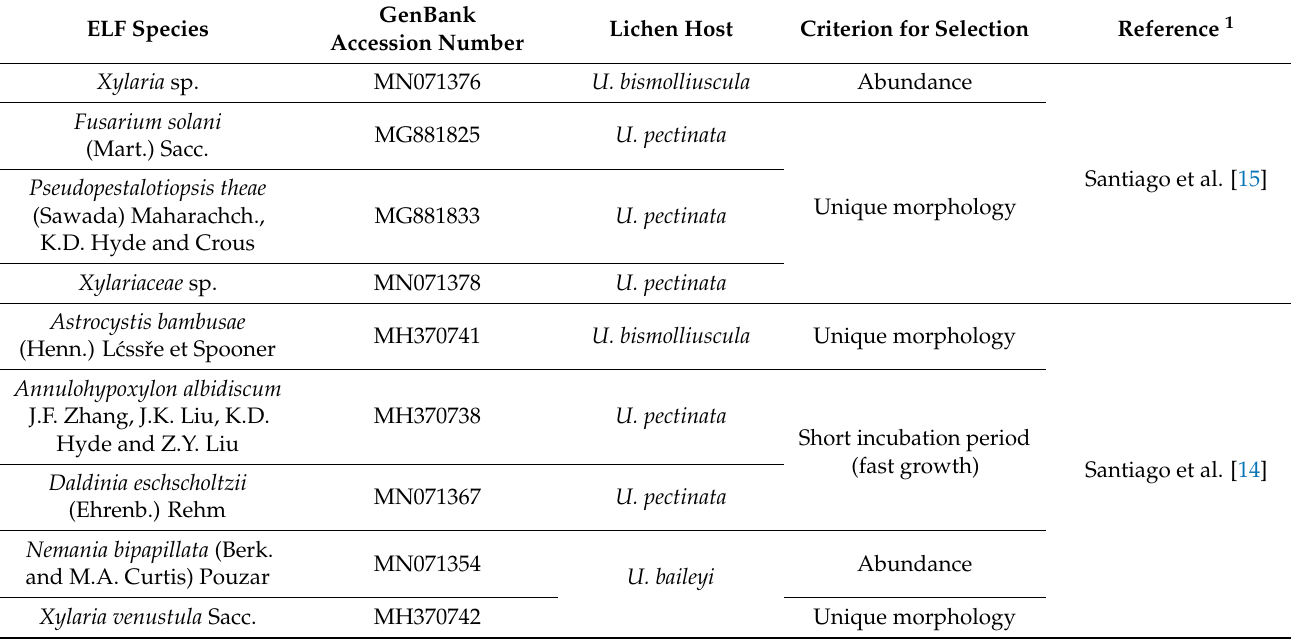
Table 1. The nine endolichenic fungi (ELF) species isolated from Usnea lichens collected from Bukit Larut, Malaysia (MY), and Sagada, Philippines